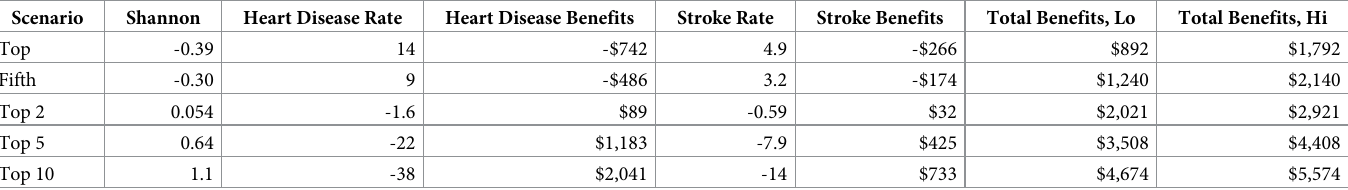
Fig 4. Change in Shannon index by number of genera targeted for simulated LA planting. Figure Notes: Data for 61 zip codes that are at least partly within the boundaries of the city of Los Angeles, California, and are in the bottom 50 th percentile in terms of total trees. The simulation evenly splits a total of 50 newly planted trees per zip code under five scenarios, each corresponding to a box plot: A single genus (the most common in LA, “top” and the fifth most common), as well as evenly splitting plantings across two, five, and ten genera. For example, in the top five genera scenario, each genus would increase the total trees by 50/ 5 = 10 trees. The Shannon Diversity Index is recalculated for each scenario and boxplots show the distribution in the change in the Shannon across 61 zip codes. https://doi.org/10.1371/journal.pone.0254973.g004 Table 4. Avoided mortality benefits for Los Angeles tree planting